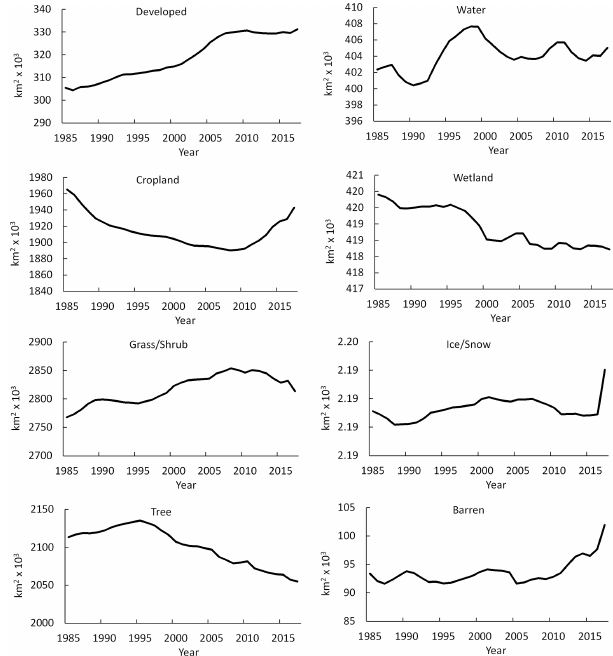
Figure 7. Areal variations in eight primary land cover types from 1985 to 2017 in